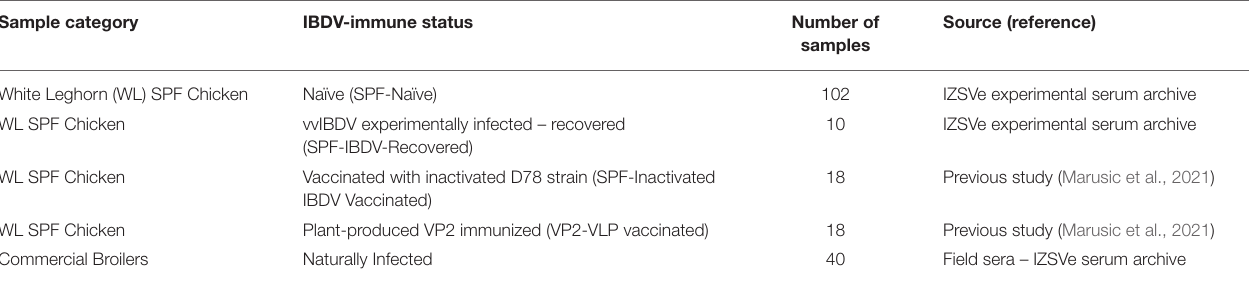
TABLE 1 | Details of the source of the sera used for His-VP3 ELISA optimization and performances evaluation. Sample